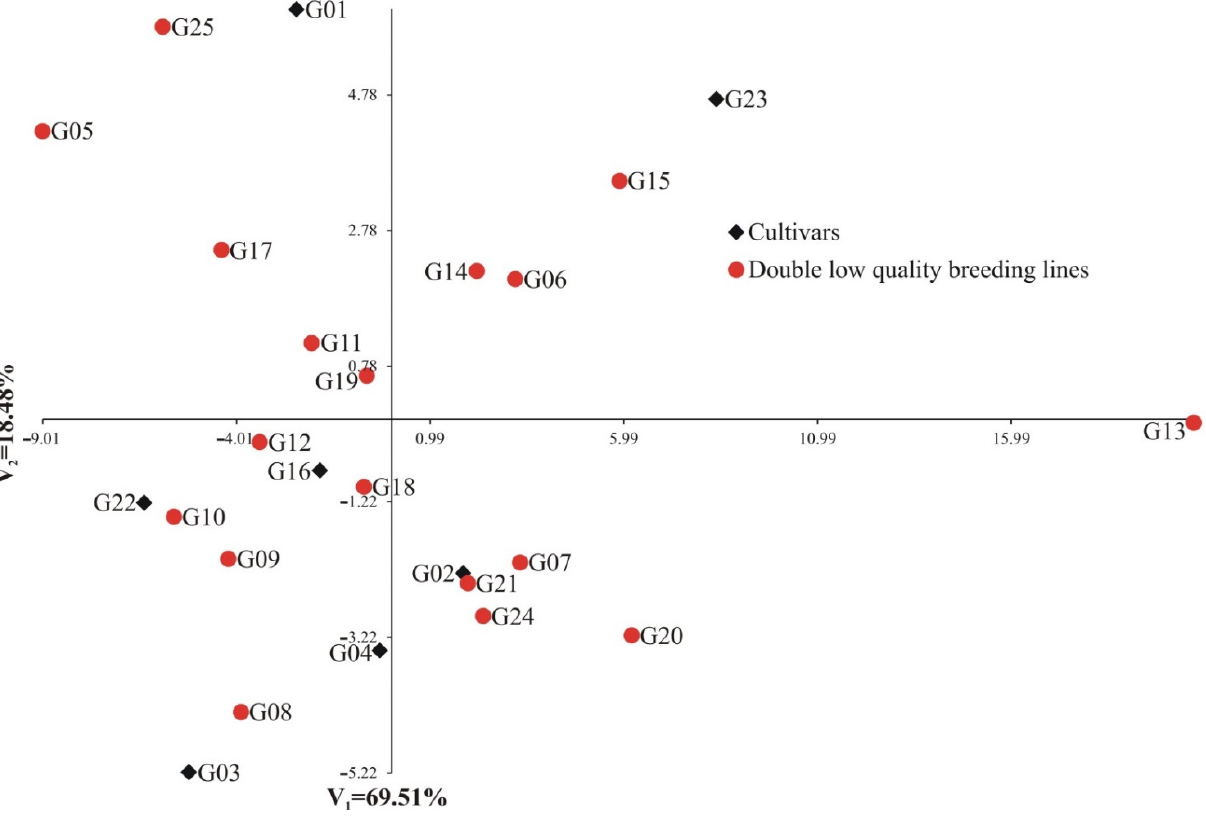
Table 8. Mean values ± standard deviations (s.d.) for the beginning of flowering of winter oilseed rape genotypes in particular environments.